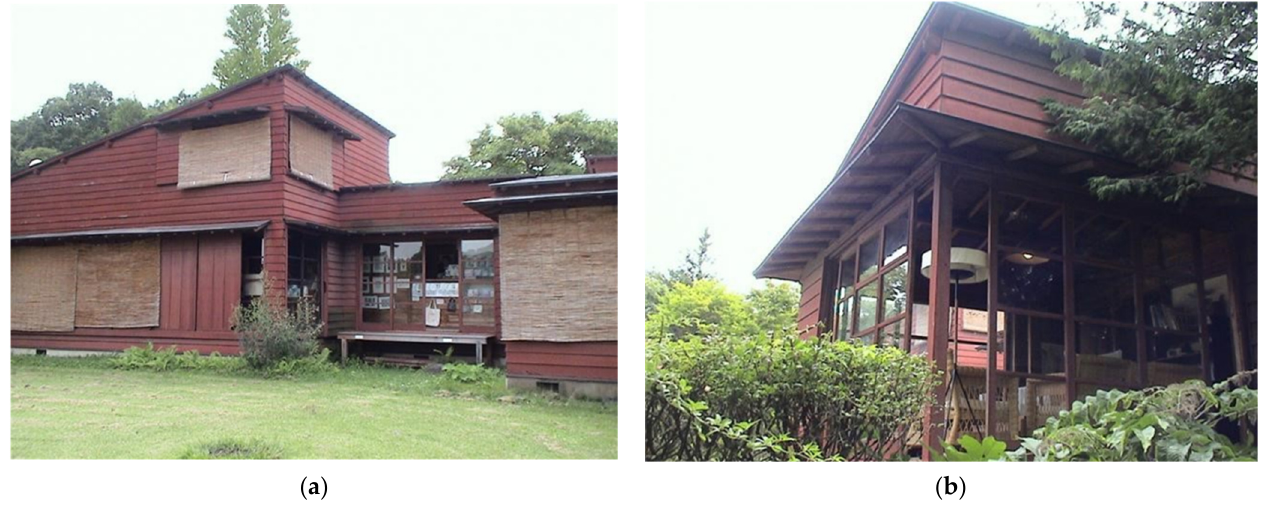
Figure 4. Raymond’s Kuruizawa summer studio (reconstruction). A vernacular reconstruction of Le Corbusier’s sketch for the Errazuriz House at Zapallar, near Valparaiso (Chile). ( a ) General outlook; ( b ) external view of the studio. Source: